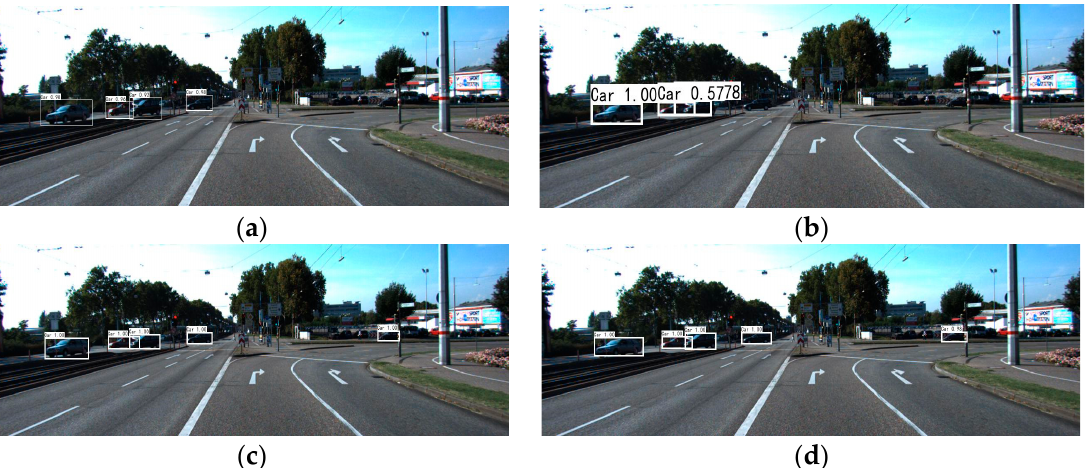
Figure 9. Low-light scenes. ( a ) Faster R-CNN detection e ff ect, ( b ) SSD detection e ff ect, ( c ) YOLOv3 detection e ff ect, ( d ) MobileNetv2_CA detection e ff ect.